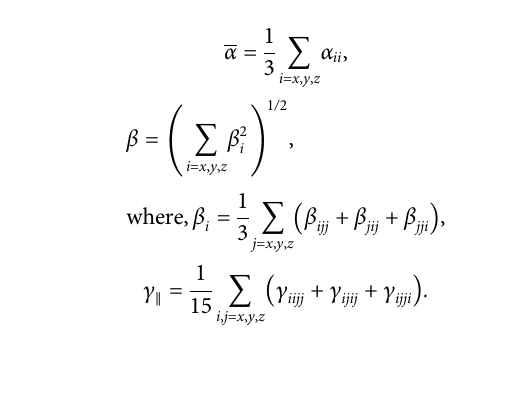
FIGURE 2 | The Schematic representation of the reaction path for (A) Li 3 @B 40 ; (B) Li 3 @C 60 systems considered in the study. The values without parentheses are calculated Δ G values at gas phase. The values within parentheses and within square brackets are calculated Δ G values at toluene and benzene solvent phases,